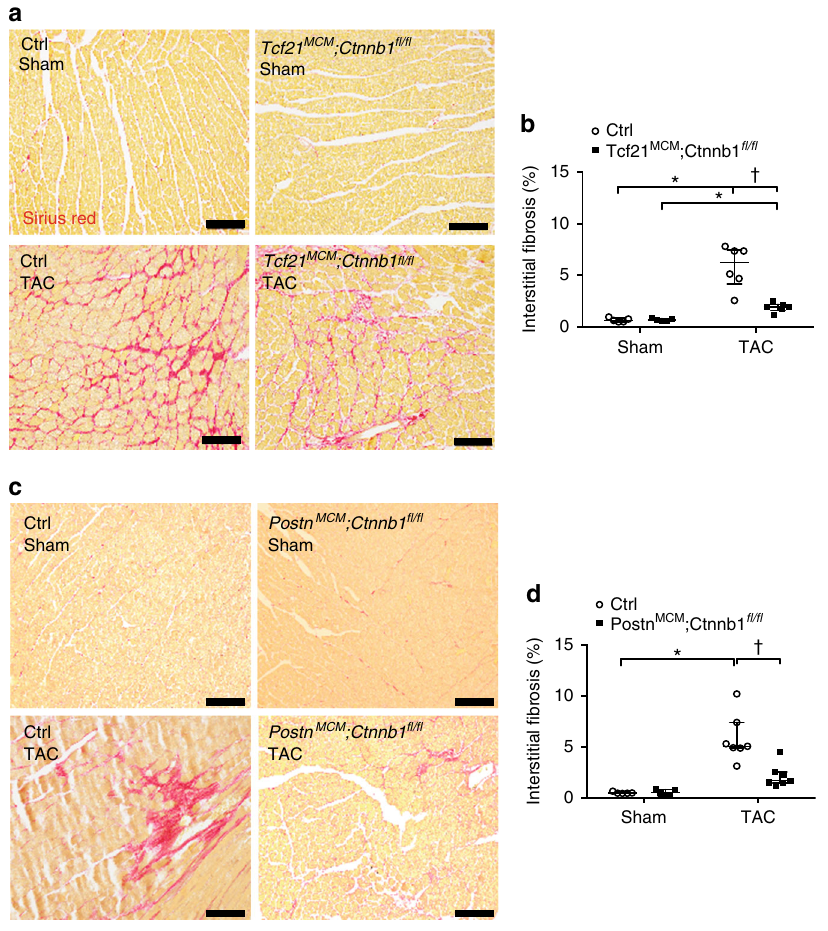
Fig. 4 Loss of β -catenin in Tcf21 or Postn lineages leads to reduced interstitial cardiac fi brosis 8 weeks after TAC. a , c Heart sections were stained with Sirius Red to visualize fi brosis ( red ). Representative images of interstitial fi brosis are shown for Tcf21 MCM ;Ctnnb1 fl / fl ( a ) and Postn MCM ;Ctnnb1 fl / fl ( c ) with corresponding Cre-negative controls 8 weeks after sham or TAC operations. Scale bar = 100 μ m. b , d The percent total area of interstitial fi brosis as indicated by Sirius Red staining was quanti fi ed. Data points are shown with median and interquartile ranges indicated. Statistical signi fi cance was determined by Kruskal – Wallis tests followed Mann – Whitney U tests for pairwise comparisons using Bonferonni adjustments to control for multiple testing. * P < 0.05 vs. Sham, † P < 0.05 vs. Control TAC. N = 5 – 7 mice per